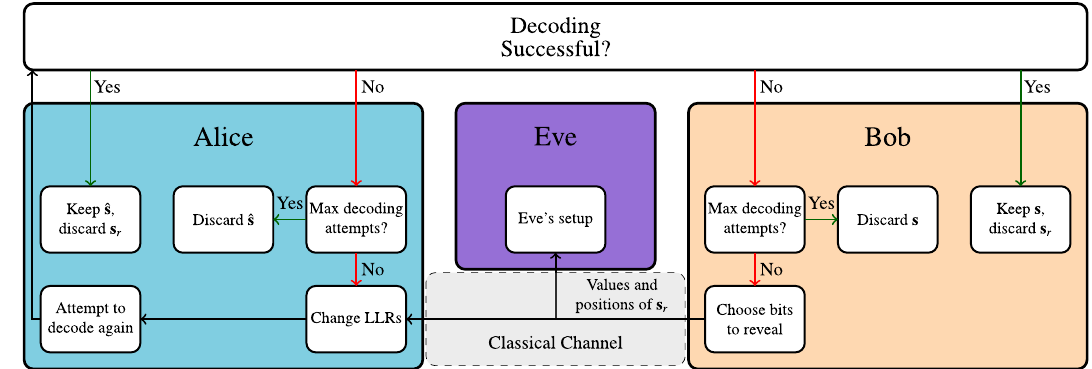
Figure 2. An overview of MDA. After every unsuccessful decoding attempt, Bob reveals bits to Alice, after which Alice will attempt to decode again. This goes on until either the decoding is successful or the maximum amount of decoding attempts has been